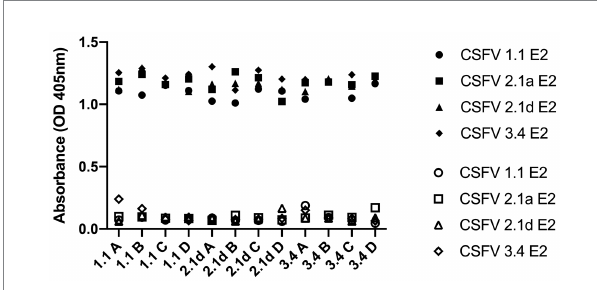
FIGURE 4 Cross-reactivity of IgG before and after G 1.1, 2.1d, and 3.4 E2 immunization in mice against different E2 glycoproteins detected by ELISA. Sera sample were collected retro-orbitally before immunization and at 70 days post immunization with different E2 glycoproteins and anti-E2 antibody levels were measured by ELISA coated with G 1.1, G 2.1a, G 2.1d, and G 3.4 E2 and read at OD 405 nm. The hollow icons represent serum samples collected prior to immunization and solid icons are at 70 days post immunization. Circular shape is against G 1.1 in-house E2-based ELISA, square shape is against G 2.1a in-house E2-based ELISA, triangular shape is against G 2.1d in-house E2-based ELISA, and diamond shape is against G 3.4 in-house E2-based ELISA.